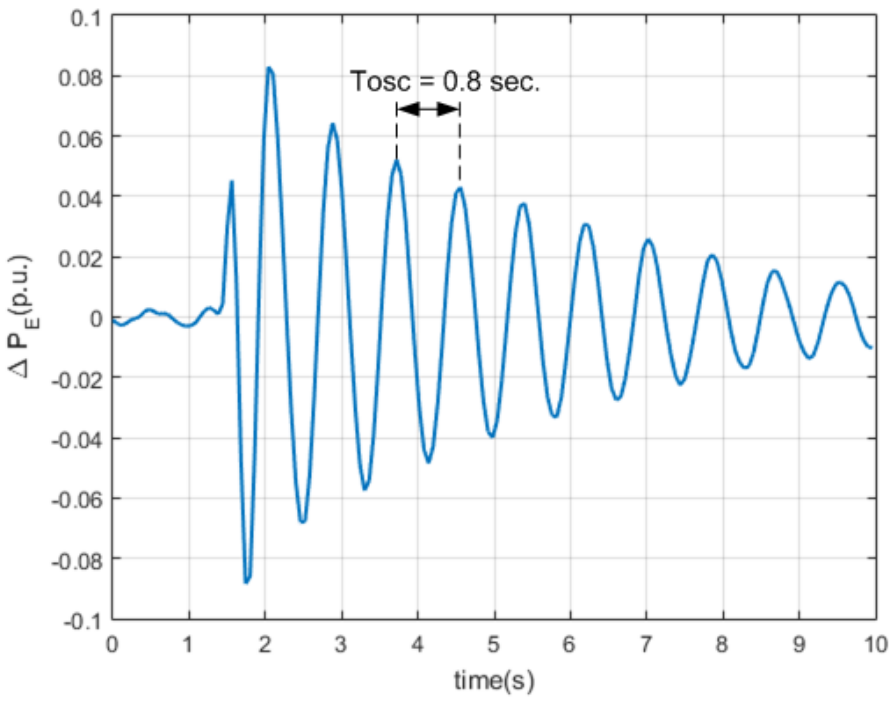
Figure 4. Impulse response of active power deviation (MEDIUM loading ( P e = 0.5 p.u)).